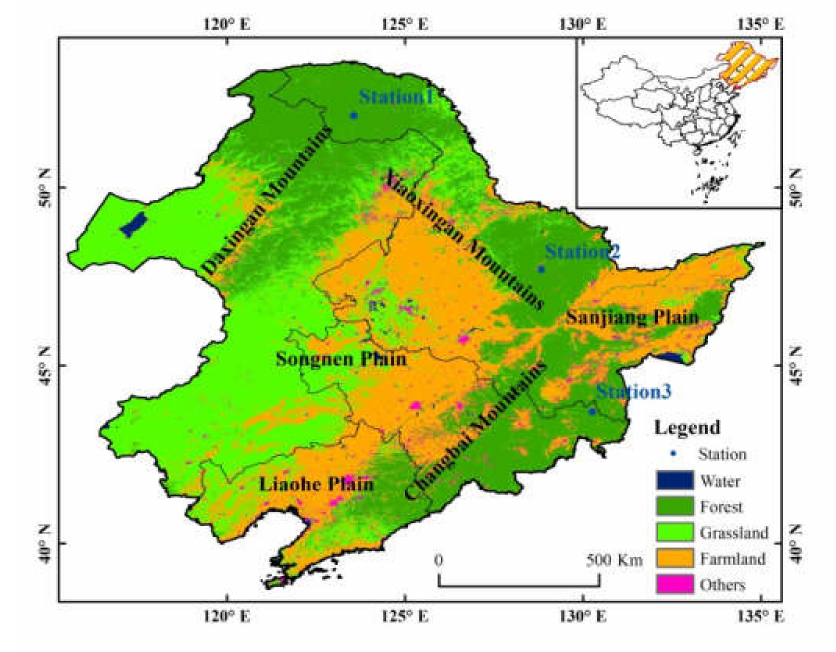
Figure 1. Land cover map of the study